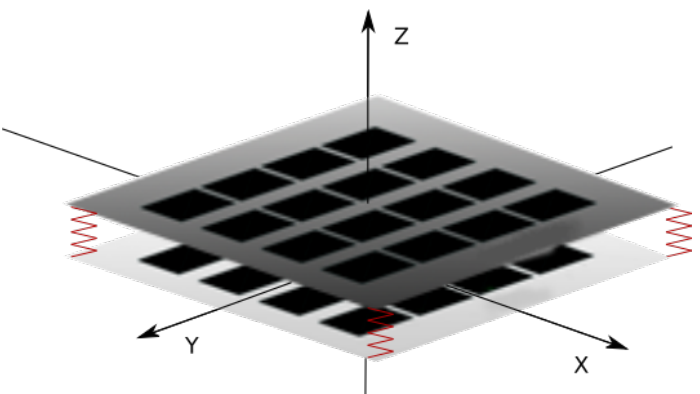
Figure 1. Diagram of the double-layer FSR (Force Sensitive Resistor) matrix.